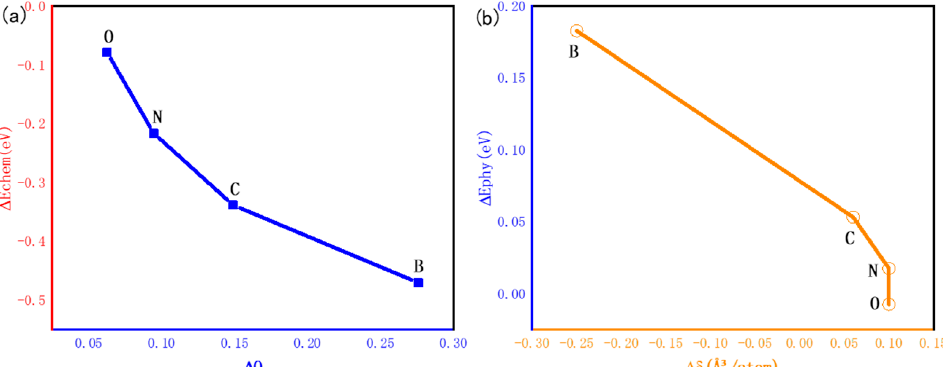
Figure 8. ( a ) The relationship between the difference in charge transfer amount and the contribution from chemical energy; ( b ) the relationship between the difference in solid solution distortion and the contribution from physical energy.